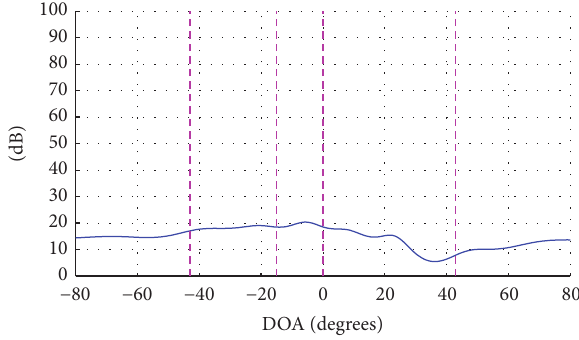
Figure 2: Capon DOA spectrum without spatial calibration. Oth- erwise the same measurement (U2SS, two uncorrelated strong transmitters; see Table 1) and processing as in Figure 10. See Section 3.5 for an explanation of the